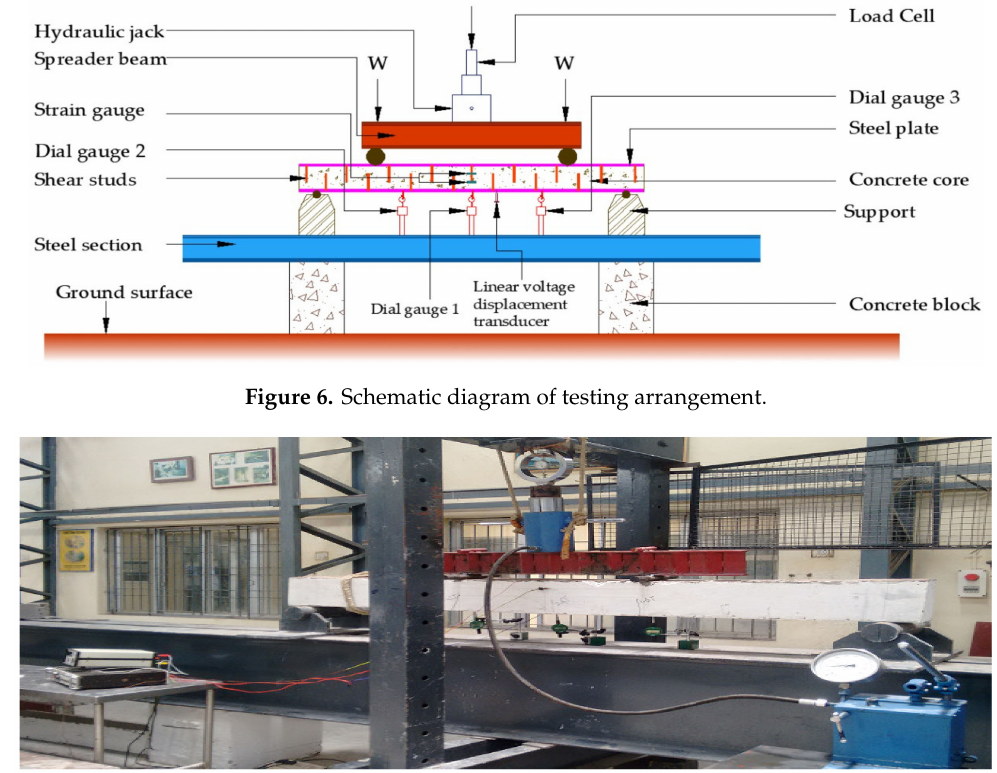
Figure 7. Typical experimental testing